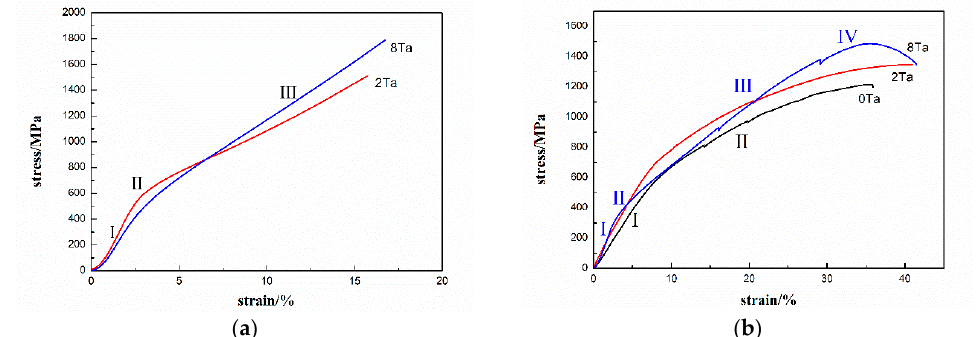
Figure 5. Compression stress–strain curves of Ir-based alloys: ( a ) Compression test at room temperature and ( b ) compression test at 1300 ◦